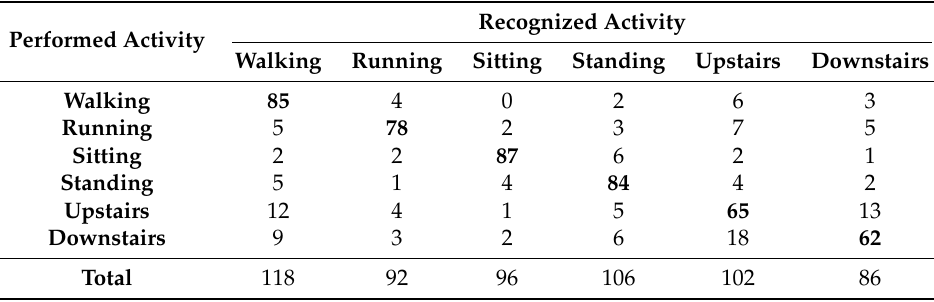
Table 4. Confusion matrix for the external training set.